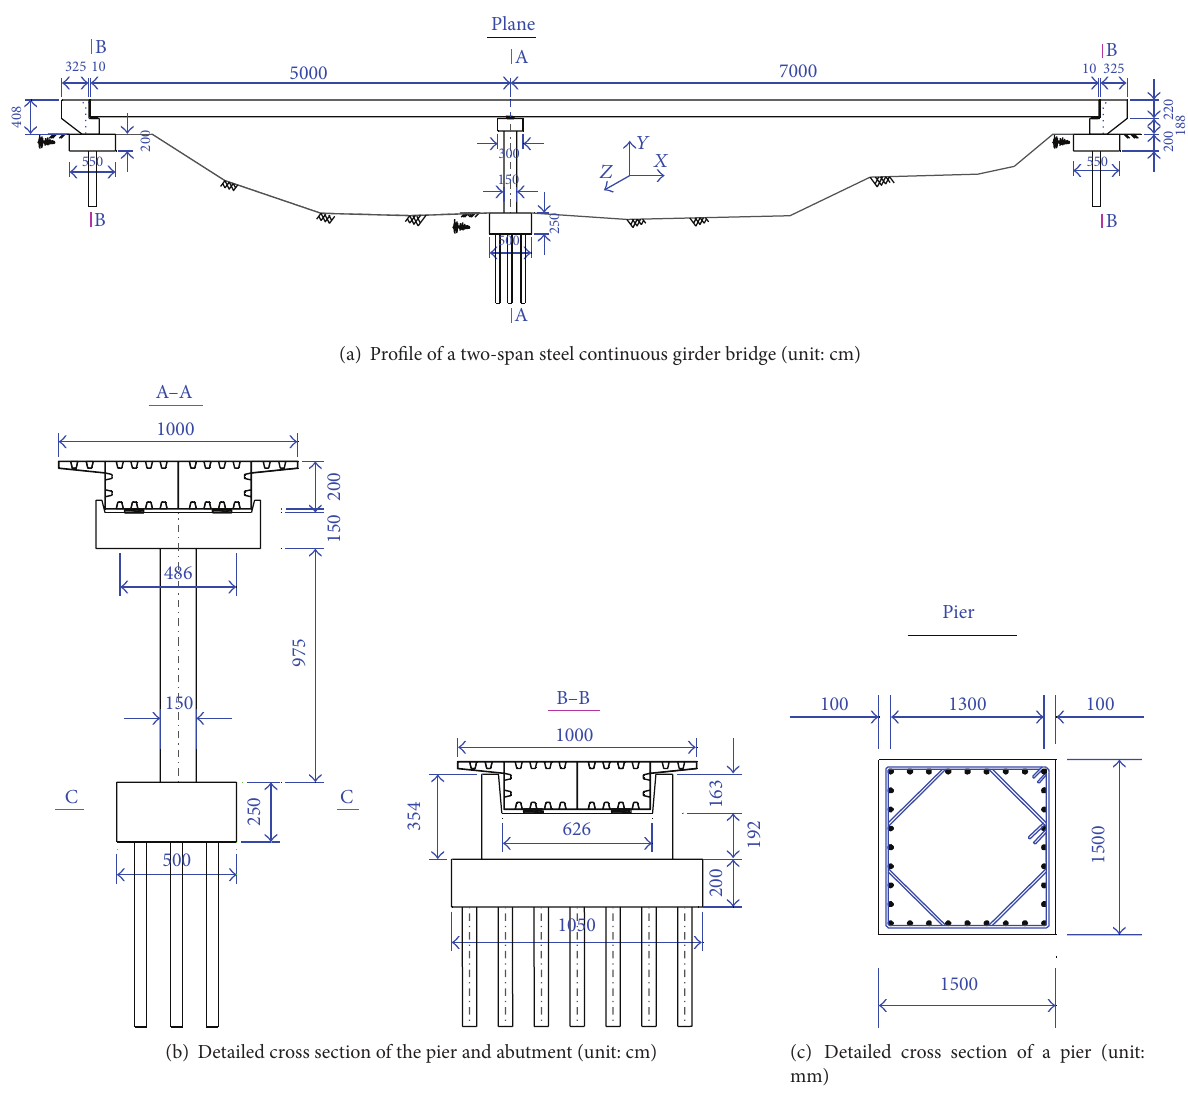
Figure 3: Profile of a steel continuous girder bridge.